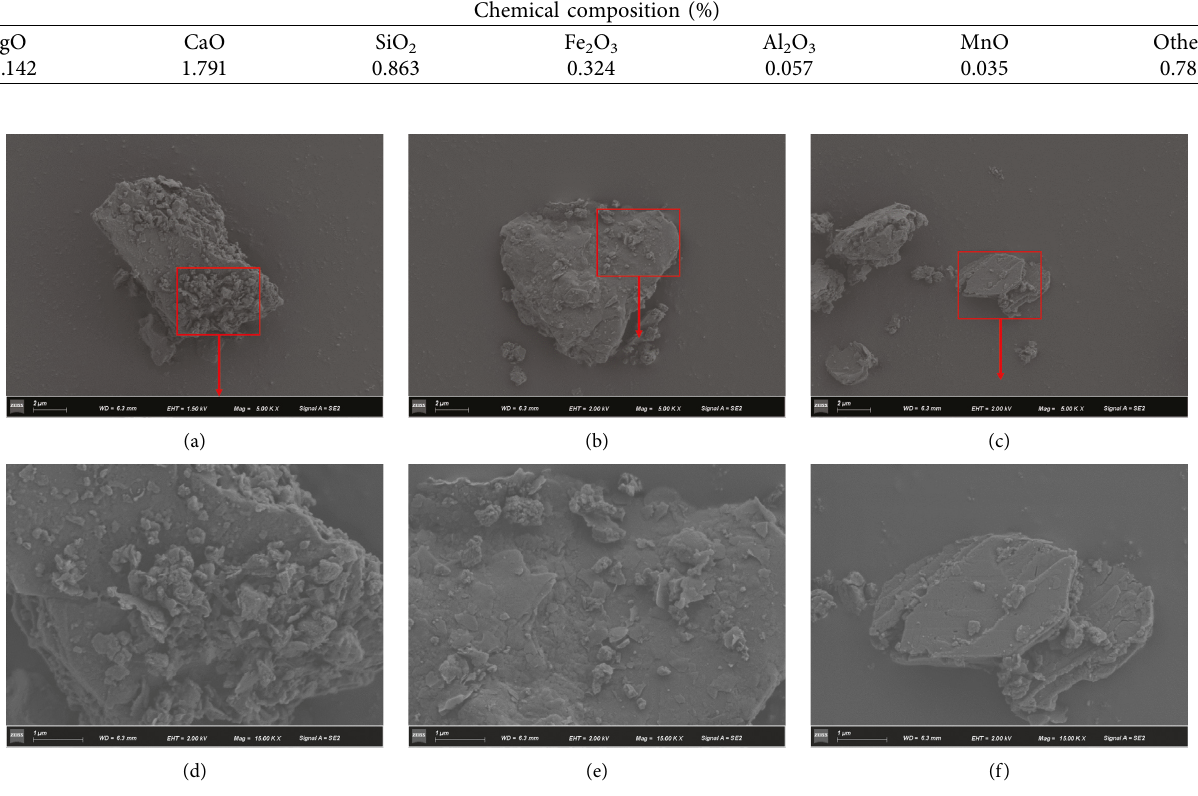
Figure 1: SEM images of WDC samples.